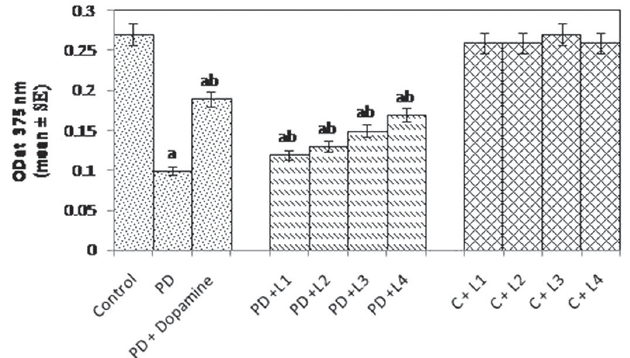
FIGURE 8 - Effect of luteolin on dopamine content measured in the brains of flies. [L1= 25 µM; L2= 50 µM; L3 = 75 µM; L4= 100 µM; PD = PD flies; Dopamine=10-3 M]. The flies were allowed to feed on the diet supplemented with luteolin for 24 days and then assayed for dopamine content. The values are the mean of 5 assays. [a - significant at p<0.05 compared to control; b - significant at p<0.05 compared to PD